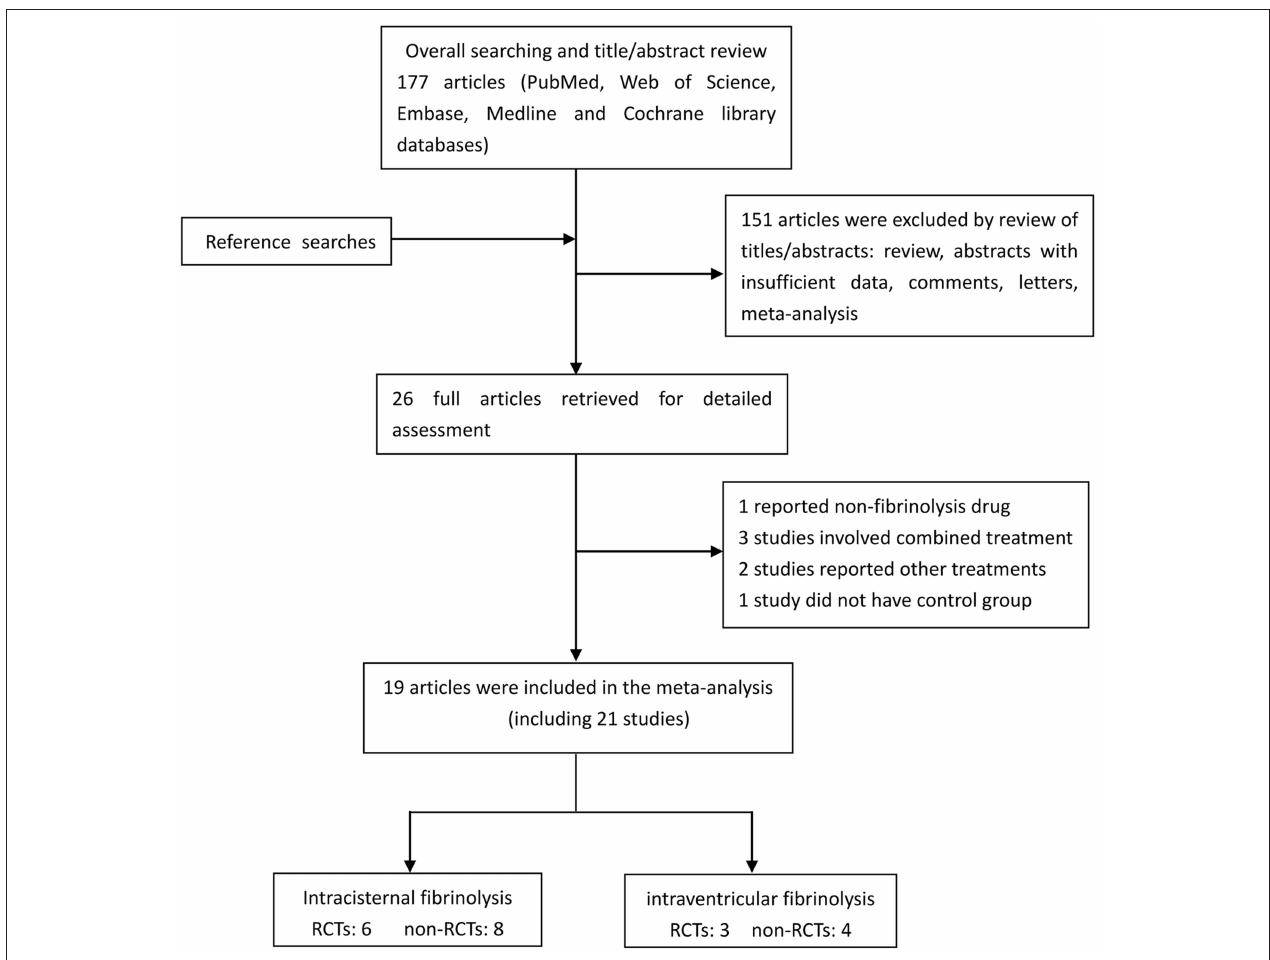
FIGURE 1 | Flow diagram showing the selection of eligible